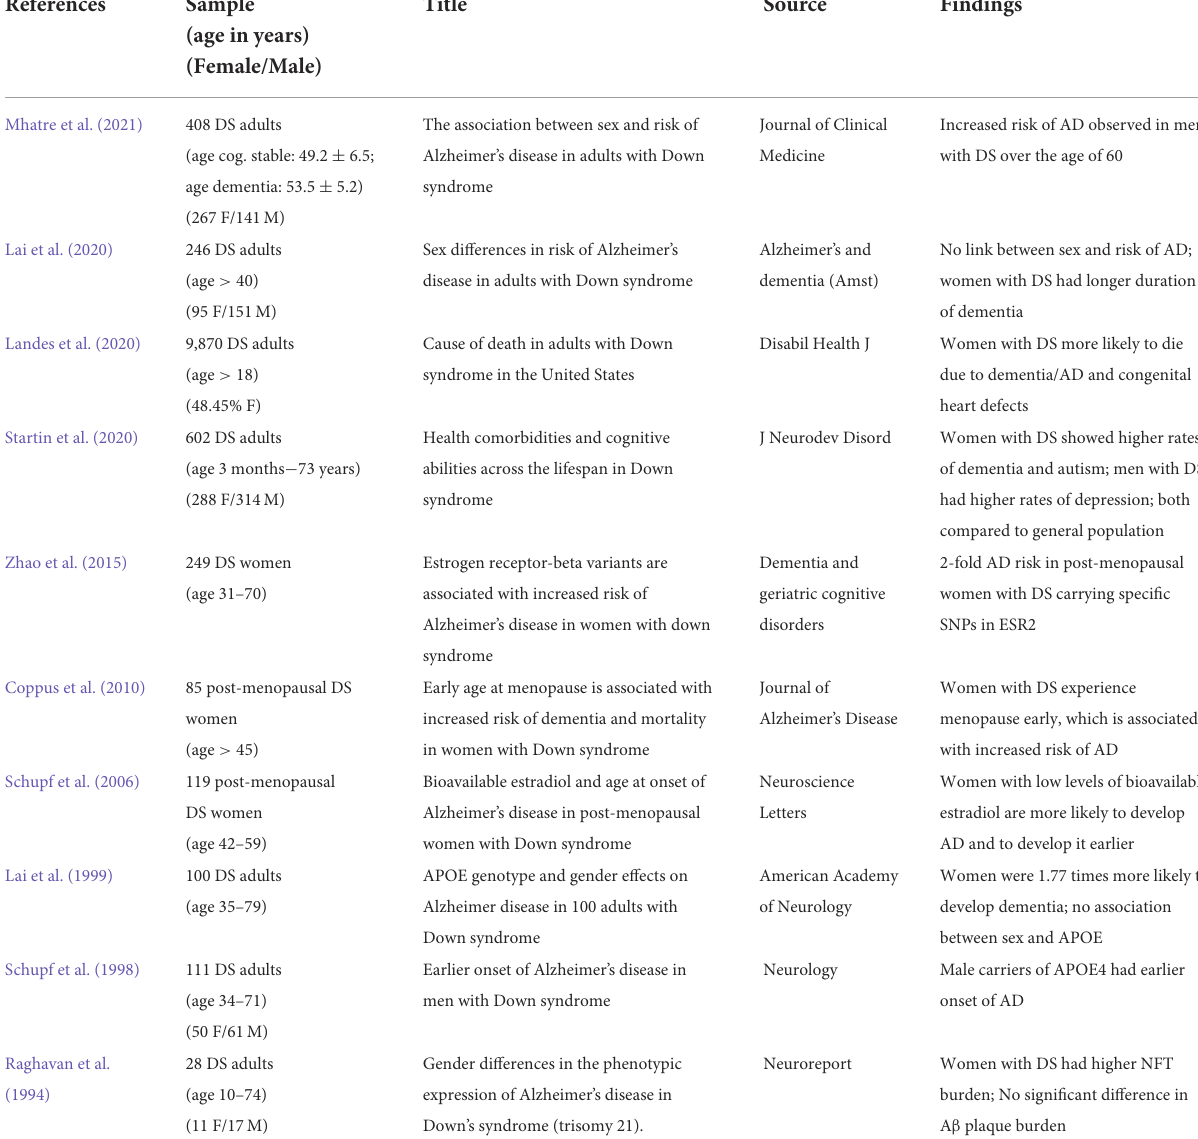
TABLE 1 Clinical studies addressing sex differences in dementia in Down